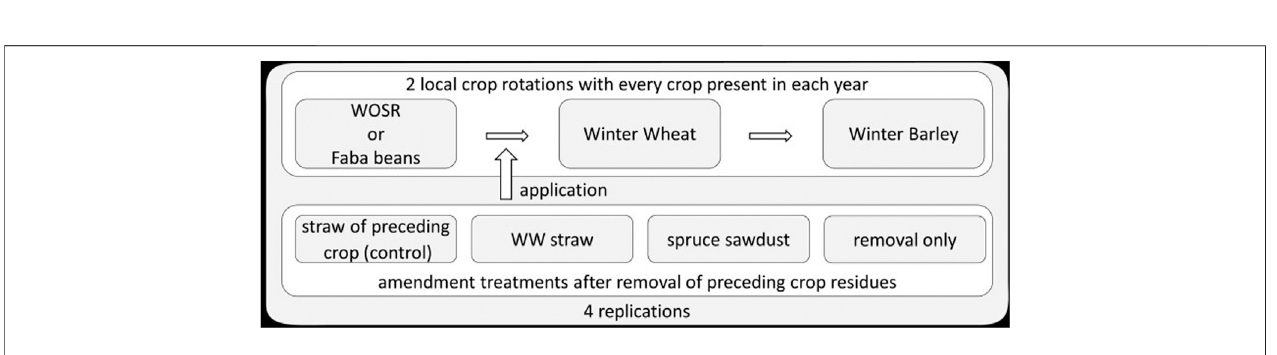
FIGURE 2 | Scheme of the experimental setup; replications equal